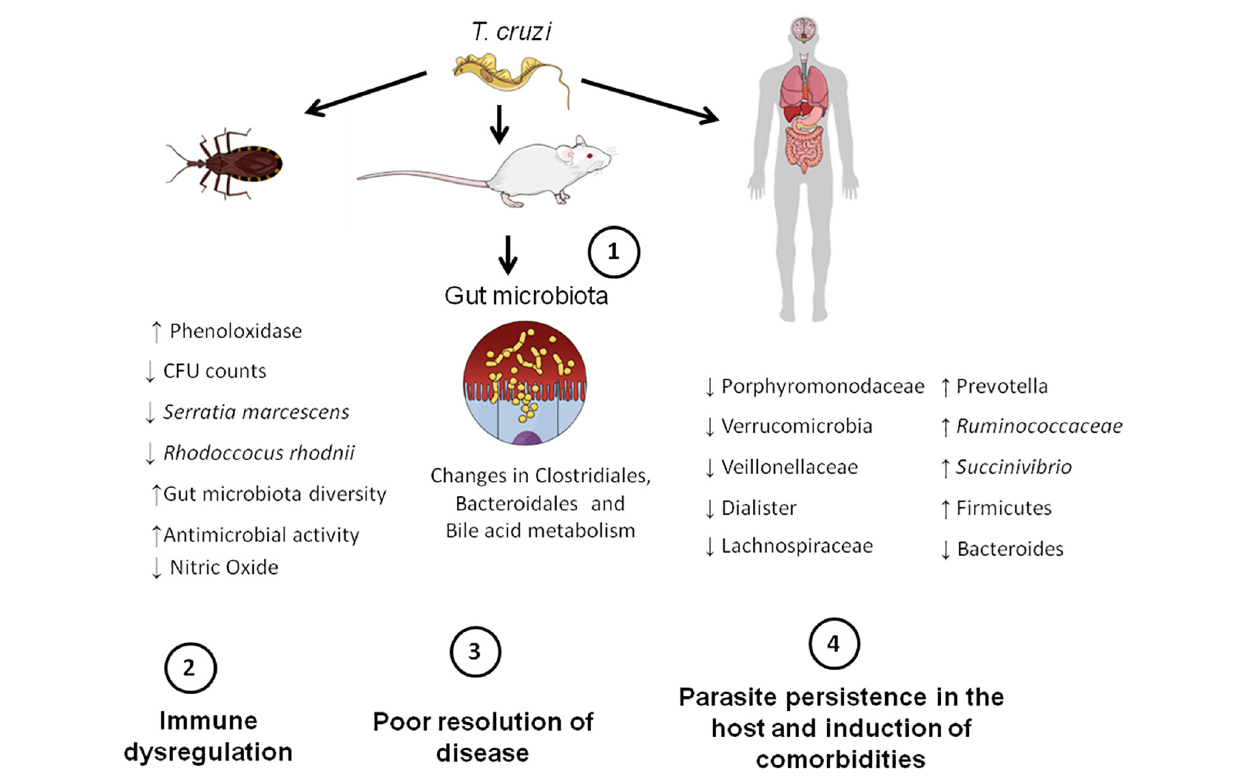
FIGURE 2 | Microbiota-host communication pathways in CD. Firstly, T. cruzi establishes infection in the mammalian (mice and human) and insect hosts (insect vectors). This initial step triggers gut microbiota changes in the aforementioned hosts. For example, in insects, infection leads to a decreased number of bacterial species that possess trypanolytic activity, such as Serratia marcescens , which increases the susceptibility of the host to T. cruzi infection. In mice, changes in the order Bacteroidales and Clostridiales, as well in the bile acid metabolism take place. In humans, there is an overall increase in Firmicutes phylum and decrease in Bacteroides. These gut microbiota changes induced by the parasite lead to immune dysregulation and consequently poor resolution of disease. Finally, the parasite persists in the host and is able to induce comorbidities, such as major depressive disorder (MDD).